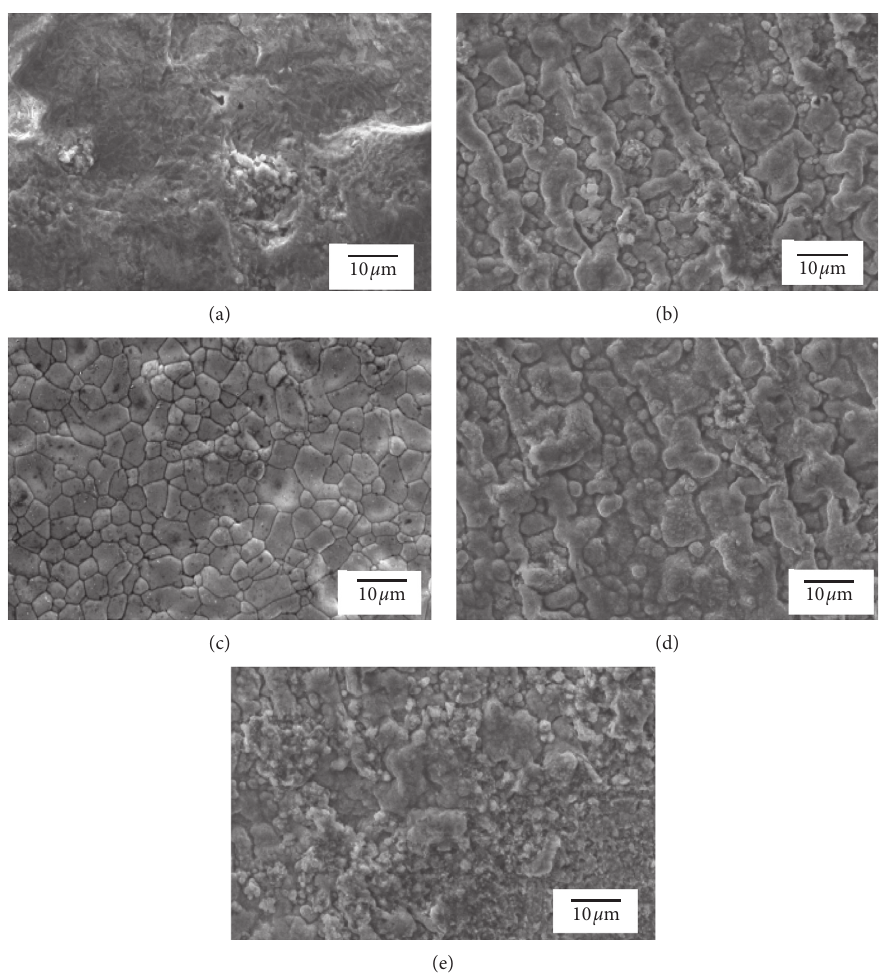
Figure 2: SEM morphology of the coating surface after isothermal oxidation for 100h. (a) No CeO CeO 2 . (d) Adding 3% CeO 2 . (e) Adding 4% CeO 2